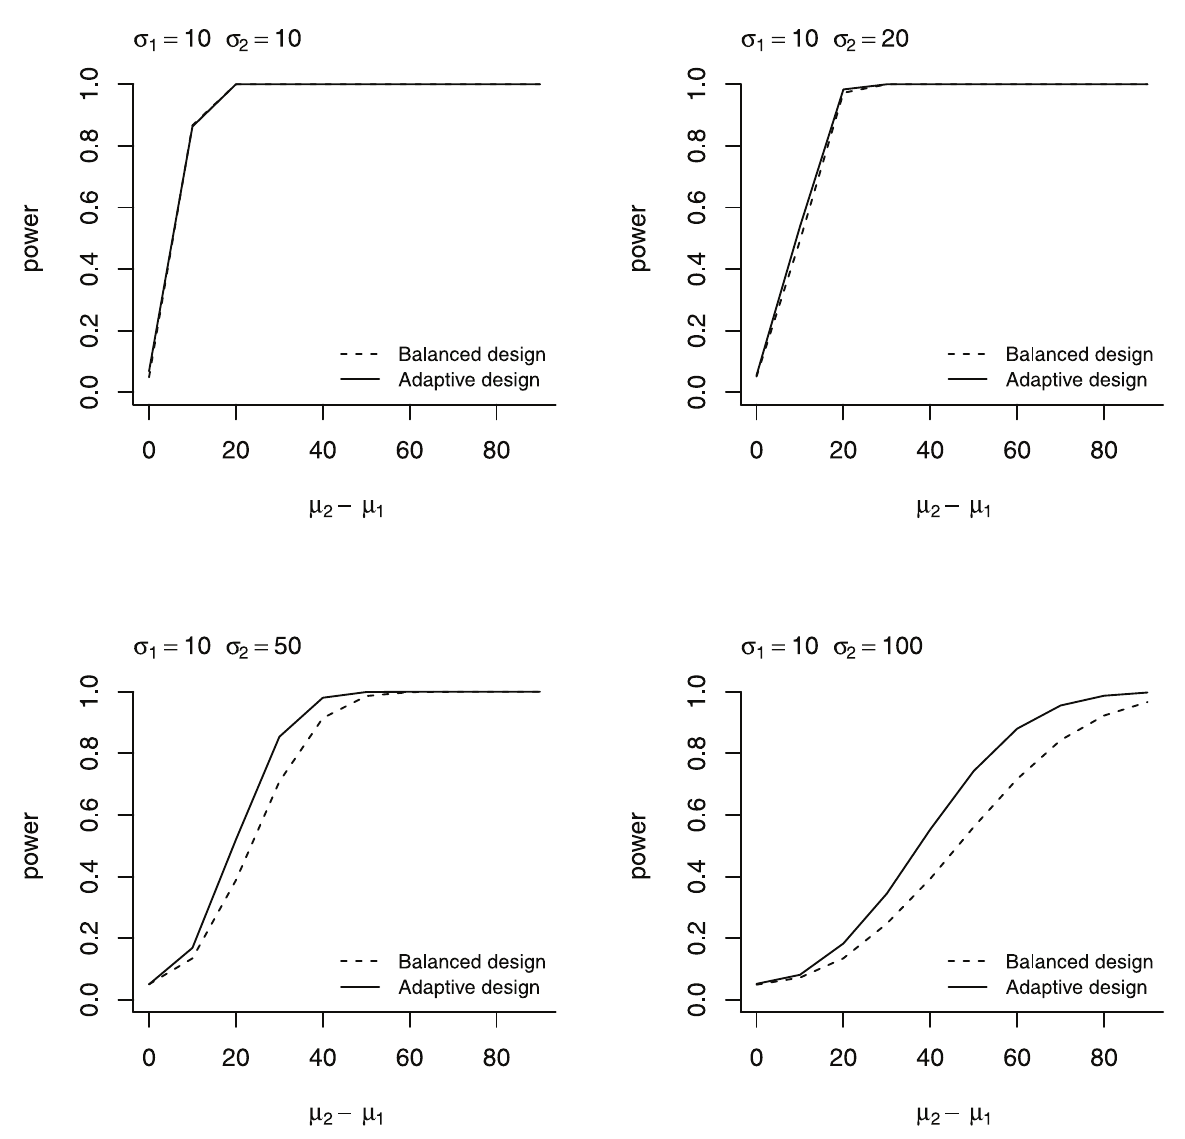
Fig 1. Power analysis. This figure compares statistical power between the balanced design and the adaptive design with respect to μ 2 − μ 1 at σ 1 = 10 and σ 2 = 10, 20, 50,